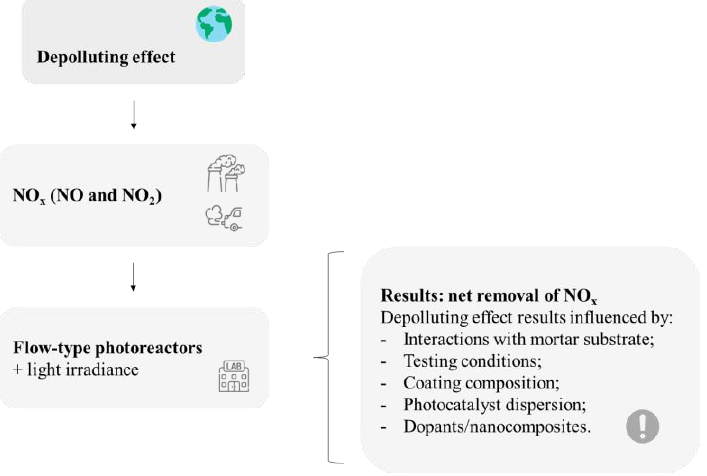
Figure 7. Main recurrent issues reviewed on the depollution effect of mortar samples with thin TiO 2 -based coatings. This figure has been designed using resources from Flaticon.com (Freepik, Tempo_doloe, turkkub).